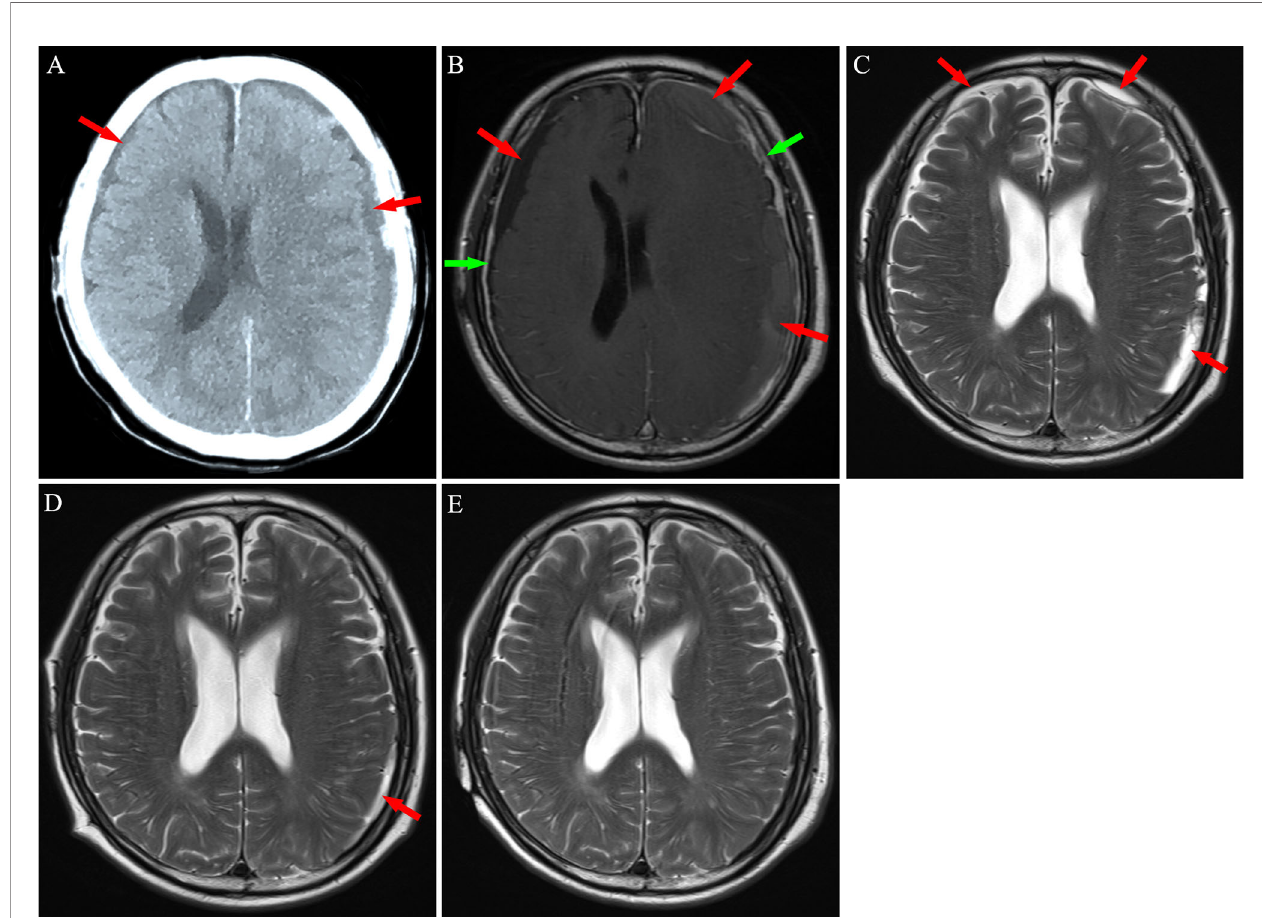
FIGURE 4 | Neuroimaging fi ndings for Patient 3. (A) Computed tomography revealed bilateral chronic subdural hematoma (red arrows). (B) After 2 weeks of atorvastatin treatment plus low-dose dexamethasone, magnetic resonance imaging revealed an increase in the hematoma, with signi fi cant enhancement of the dura mater (green arrows) post-injection of contrast agent. (C, D) After chemotherapy, subdural mass was signi fi cantly absorbed in 8-14 weeks. (E) A 5 months follow-up MRI exhibited no hematoma in the subdural